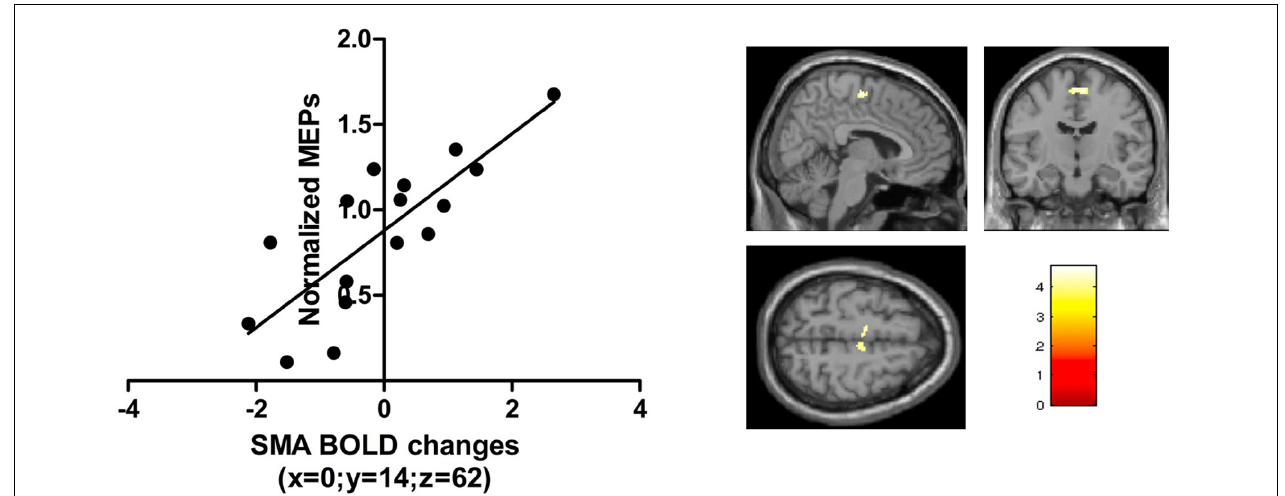
FIGURE 6 | The t -scores in the contrast visuomotor tracking vs visual baseline correlated with the normalized TMS amplitudes just after anodal TDCS in a region in the bilateral SMA [peak activation [0, -14, 62]; p < 0.05 FWE; small volume correction; 10 mm sphere based on Lee et al.